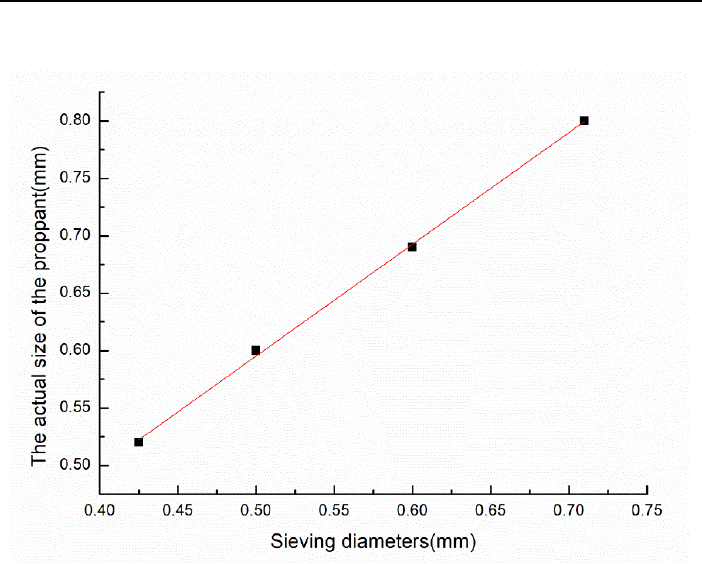
Figure 7. Comparisons of actual proppant diameters with sieving diameters.